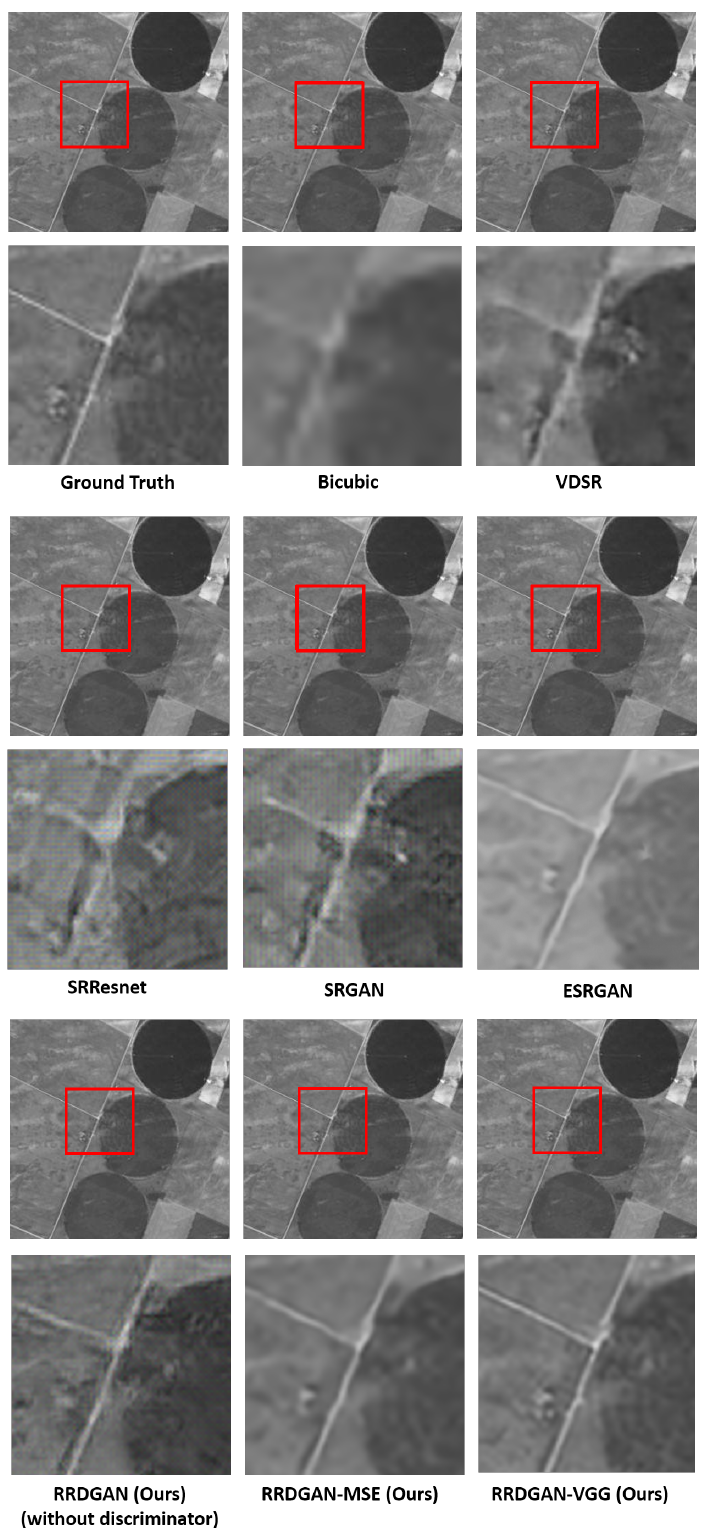
Figure 8. Comparison results among different methods of “CircularFarmland”, scale factor is